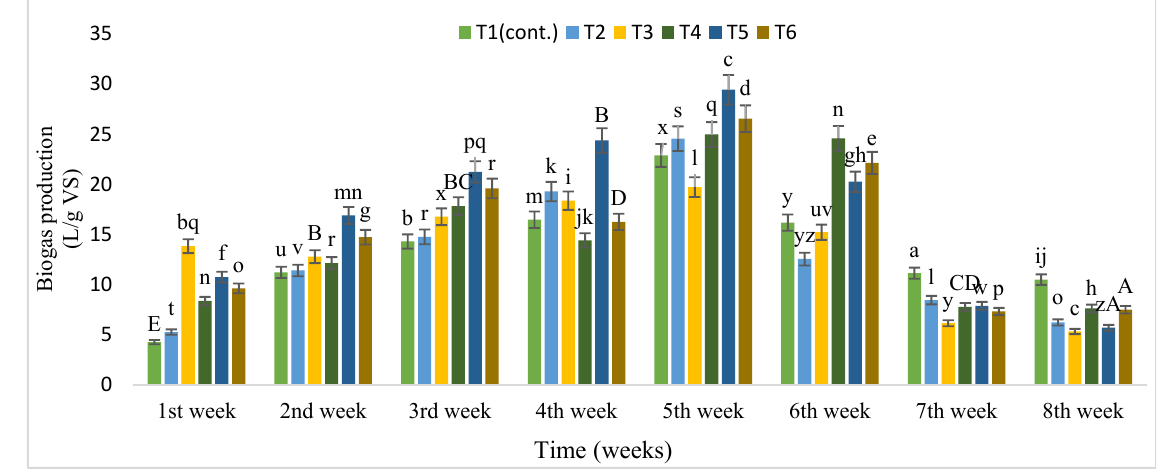
Figure 7. Biogas production (L/ g of VS) from cattle manure with different concentrations of IONPs under batch digestion. Bars with different letters indicate significantly different values at p ≤ 0.05.